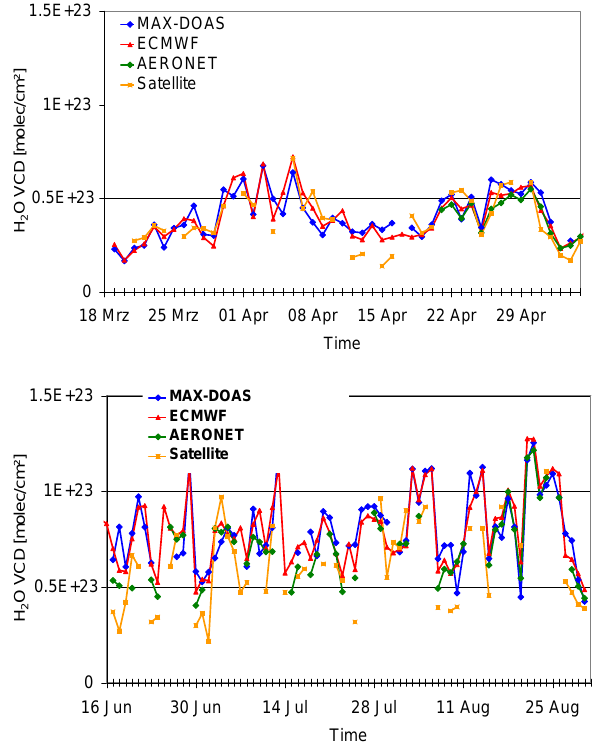
Fig. 12 Time series of daily average H 2 O VCDs derived from the different data sets. Top: first Fig. 12. Time series of daily average H 2 O VCDs derived from the part of the MAX-DOAS measurements (19. March – 04 April). Bottom: second part of the MAX-DOAS measurements (17 June – 30 August). different data sets. Top: first part of the MAX-DOAS measurements (19 March–4 April). Bottom: second part of the MAX-DOAS mea- surements (17 June–30 August).